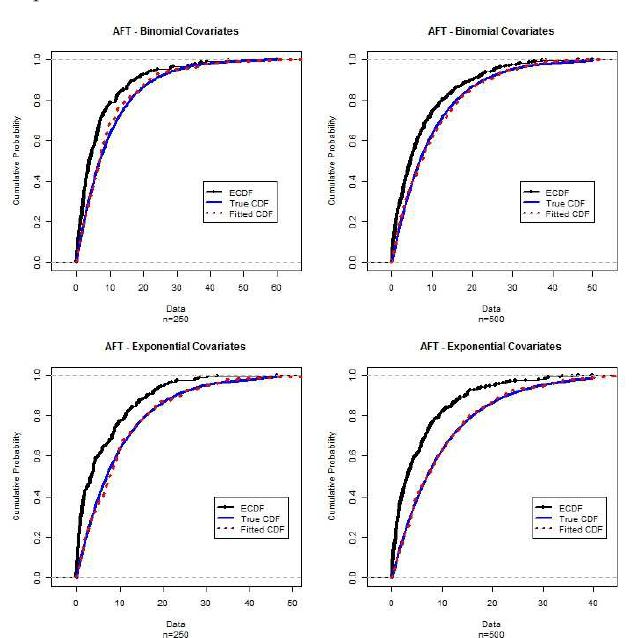
Figure 2 – Exponential AFT model